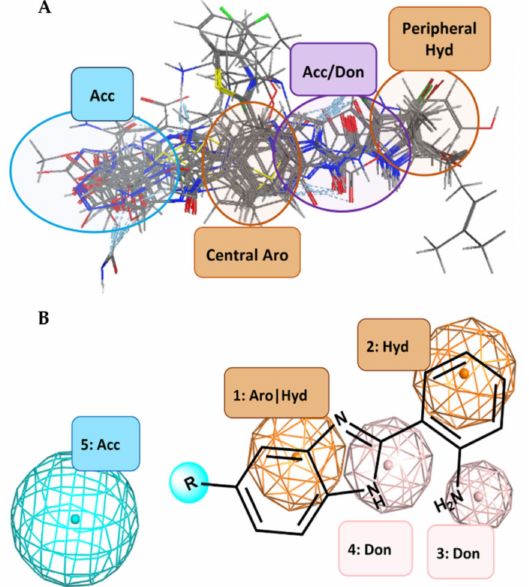
Figure 2. ( A ) Structural alignment of the 18 ligands from the training set and visual identification of common structural features. ( B ) Superimposition of the 2-(2-aminophenyl)-5(6)-substituted- benzimidazole scaffold with the selected pharmacophore model. Acc-Hydrogen bond acceptor; Aro- Aromatic; Don-Hydrogen bond donor; Hyd-Hydrophobic. R = (methylsulfonyl)phenyl, (methoxy- carbonyl)phenyl and